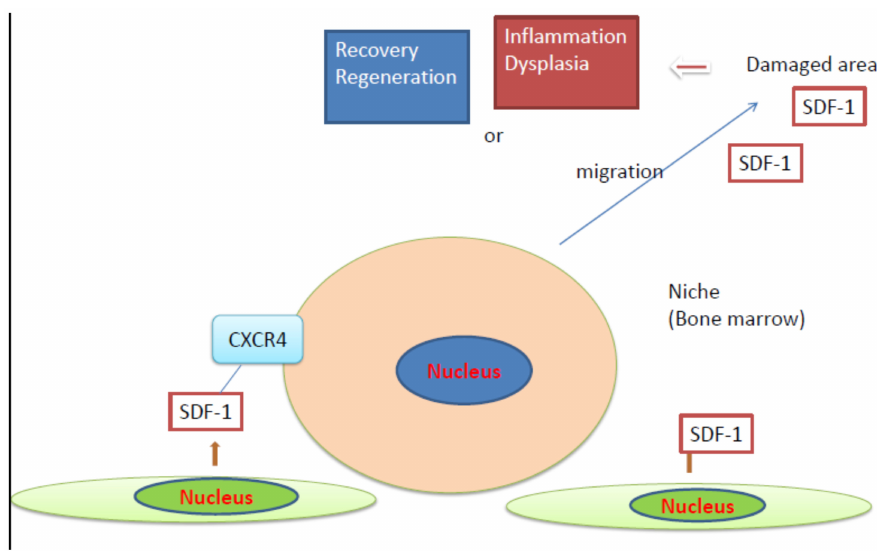
Figure 2. Action of stromal cell-derived factor (SDF)-1/CXCR4 axis in damaged